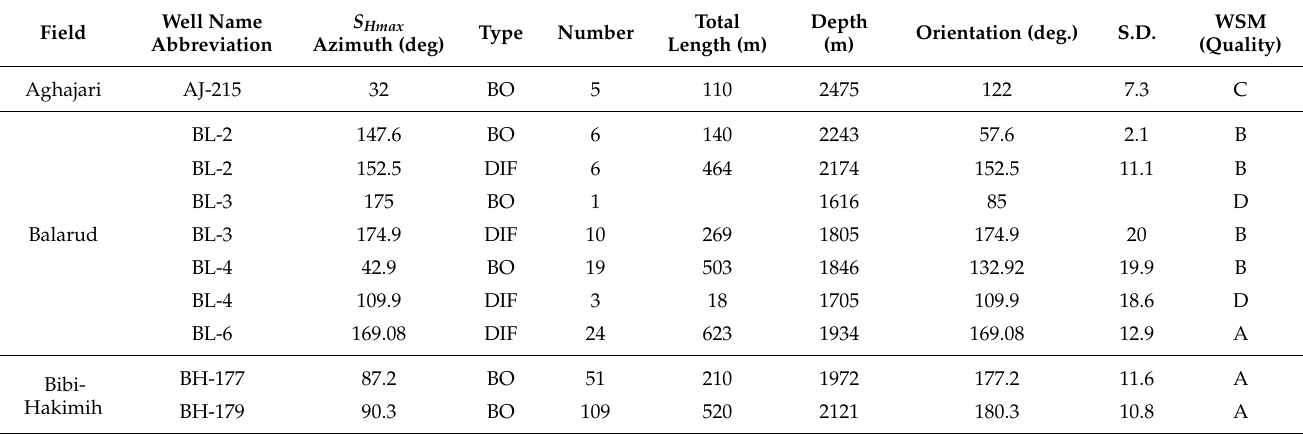
Table 1. S Hmax orientations derived from both borehole breakout (BO) and drilling induced fracture (DIF) in the different fields of the Dezful Embayment (S.D, standard deviation). S Hmax orientations are ranked from A to D according to the World Stress Map (WSM) quality ranking system.